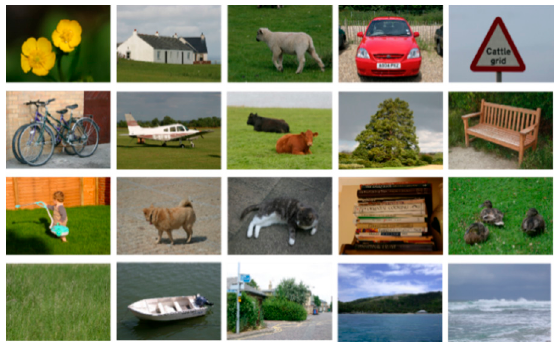
Figure 13. Example images from the MSRC dataset.